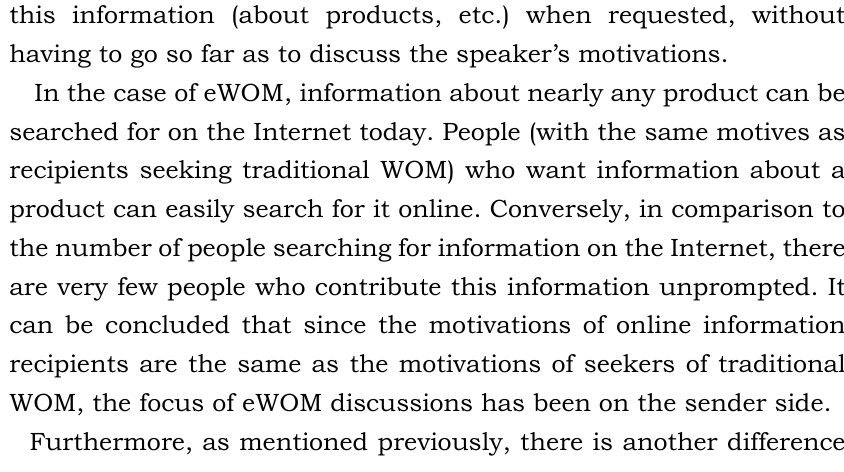
Table 2. Scope of studies of motivation for